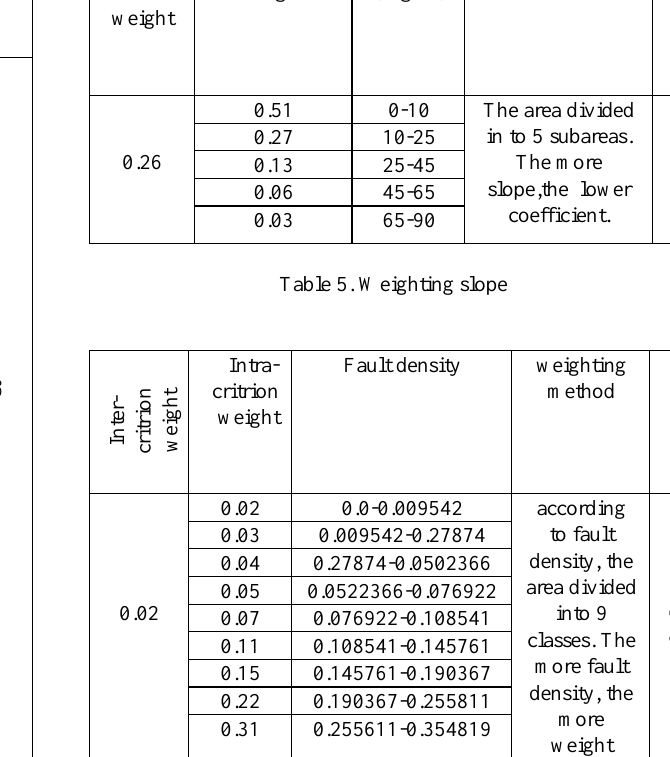
Table 5. Weighting slope